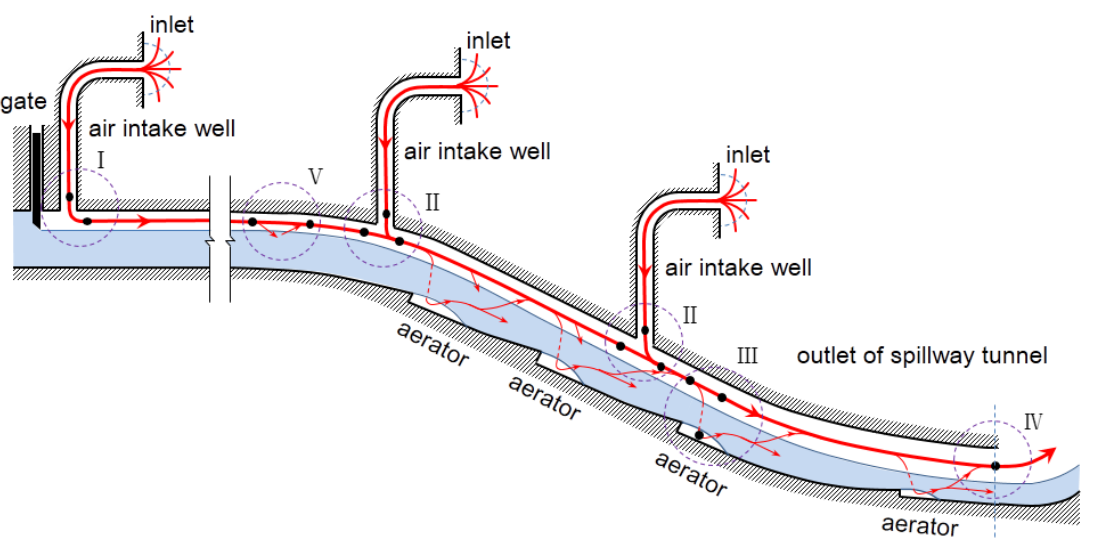
Figure 1. Schematic diagram of the multi-intake-well air supply system in a spillway tunnel. Note: Serial number of dot circles I – IV represent different connection nodes and V represents a gradually varied section.